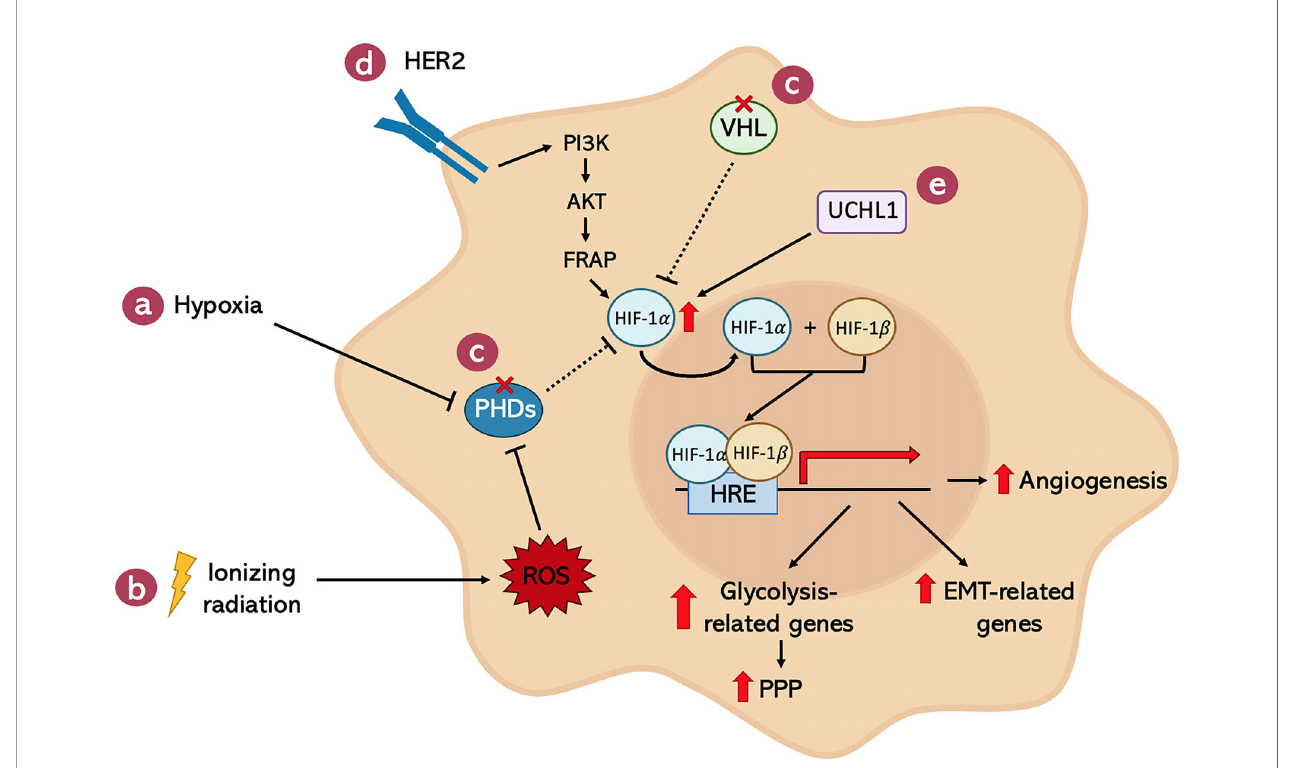
FIGURE 5 | Summary of the pathways involved in the HIF-1 transcriptional activation after IR and its downstream effectors. Several clues can lead to HIF-1 activation. The most known is the presence of (A) a hypoxic environment, a condition frequently found in most solid tumors. Also, (B) ionizing radiations induce the activity of this hypoxia-related TF by the induction of ROS. Together with these external stimuli, congenital or acquired mutations promote HIF-1 activity, such as the ones found in its negative regulators: (C) PHDs and VHL. (D) Moreover, RTK receptors, like HER2, are found to induce HIF-1, which is particularly true for certain types of tumors, like breast cancers. (E) Lastly, HIF-1 can be activated also by the aberrant function of its deubiquitinase, UCHL1. The network established by HIF-1 transcriptional activity confers cancer cells more aggressive characteristics and protects them from the harmful effects of radiation